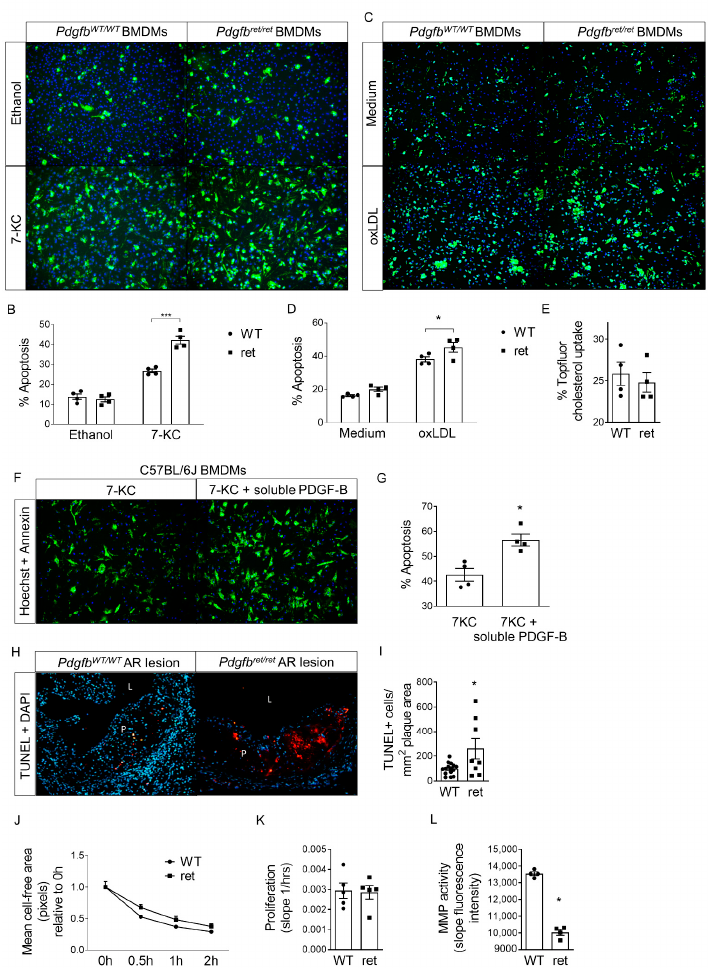
Figure 3. Increased apoptosis upon incubation with atherosclerosis-relevant stimuli and decreased MMP activity in Pdgfb ret / ret BMDMs. All experiments in ( A – E ) and ( J – L ) were performed with Pdgfb WT / WT and Pdgfb ret / ret BMDMs. Representative photomicrographs of BMDM apoptosis stained with Annexin A5 (FP488, green) and Hoechst 33342 (blue) after 24 h incubation with ( A ) ethanol or 7-ketocholesterol (7-KC) or ( C ) medium or oxidized LDL (oxLDL), with corresponding quantification ( n = 4) in ( B ) and ( D ). ( E ) Quantification of Topfluor-labeled cholesterol uptake by BMDMs after 3 h ( n = 4). ( F ) Representative photomicrographs of C57BL/6J BMDM apoptosis stained with Annexin A5 (FP488, green) and Hoechst 33342 (blue) after 24 h incubation with 7-ketocholesterol and soluble PDGF-B, with corresponding quantification ( n = 4) in ( G ). ( H ) Representative photomicrographs of TUNEL (red) and DAPI (blue) staining in Pdgfb WT / WT ( n = 15) and Pdgfb ret / ret ( n = 8) aortic root (AR) lesions and ( I ) quantification of TUNEL+ cells. P; plaque, L; lumen. ( J ) BMDM migration defined as mean cell-free area over time after scratch infliction ( n = 4). ( K ) Mean BMDM proliferation measured as change in electrical impedance over time ( n = 5). ( L ) Quantification of BMDM MMP activity with OmniMMP Fluorogenic Substrate ( n = 4). Graphs represent mean ± SEM. * p < 0.05, ** p < 0.01. Data were tested for normality (Shapiro-Wilk) and equal variances (F-test). Variables that did or did not pass were analyzed using Student’s t -test or the Mann-Whitney U test, respectively. ( B , D , J ) were analyzed using two-way ANOVA and two-way repeated measures ANOVA, respectively, including Bonferroni’s multiple comparisons